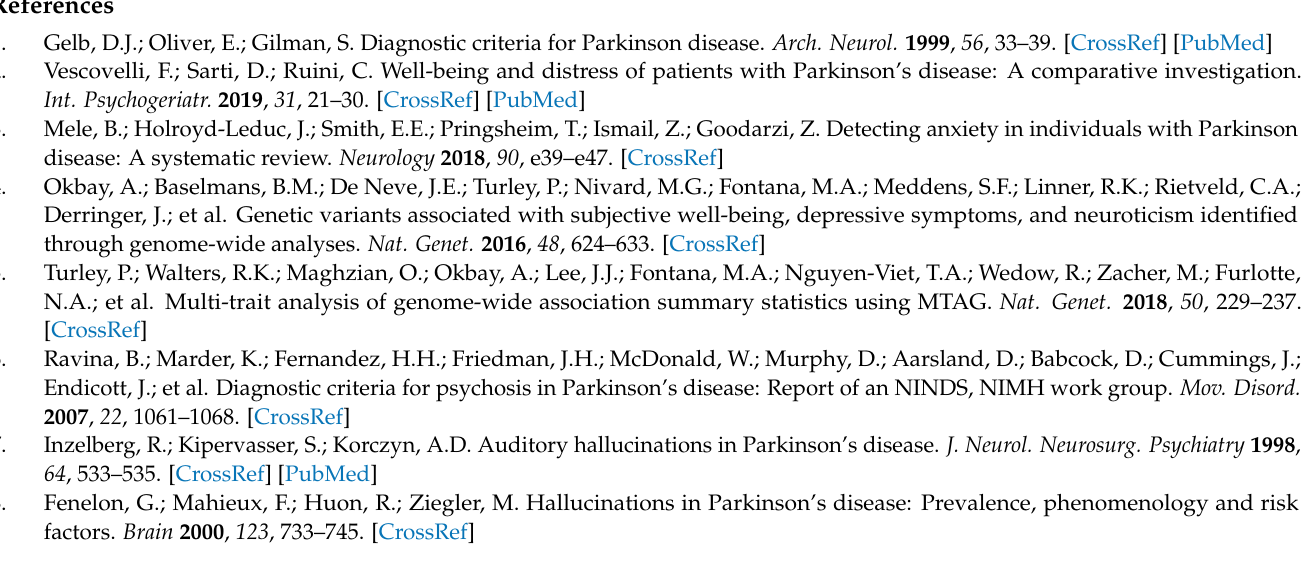
results of schizophrenia [3] (exposure trait) and Parkinson’s disease [2] (outcome trait) using MR- Egger, Table S5: Two-sample Mendelian randomization results of Parkinson’s disease [2] (exposure trait) and schizophrenia [3] (outcome trait) using MR-Egger, Table S6: Two-sample Mendelian randomization results of Parkinson’s disease [1] (exposure trait) and schizophrenia [3] (outcome trait) using IVW and WM after removing outliers that exhibit pleiotropy detected by MR-PRESSO, Table S7: Two-sample Mendelian randomization results of Parkinson’s disease [1] (exposure trait) and schizophrenia [3] (outcome trait) using MR-Egger after removing outliers that exhibit pleiotropy detected by